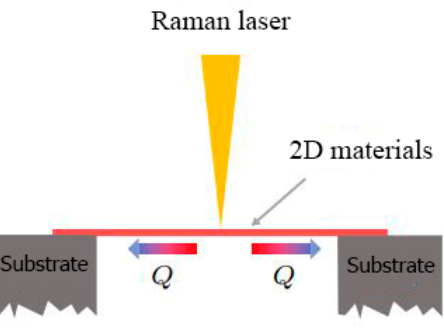
Figure 7. Raman spectroscopy schematic.